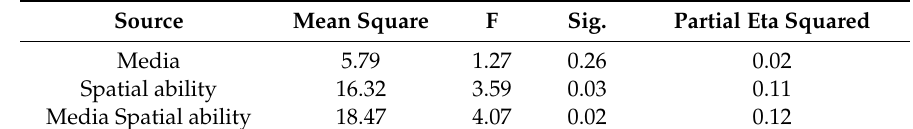
Table 2. ANOVA result for spatial ability and media on spatial recognition.